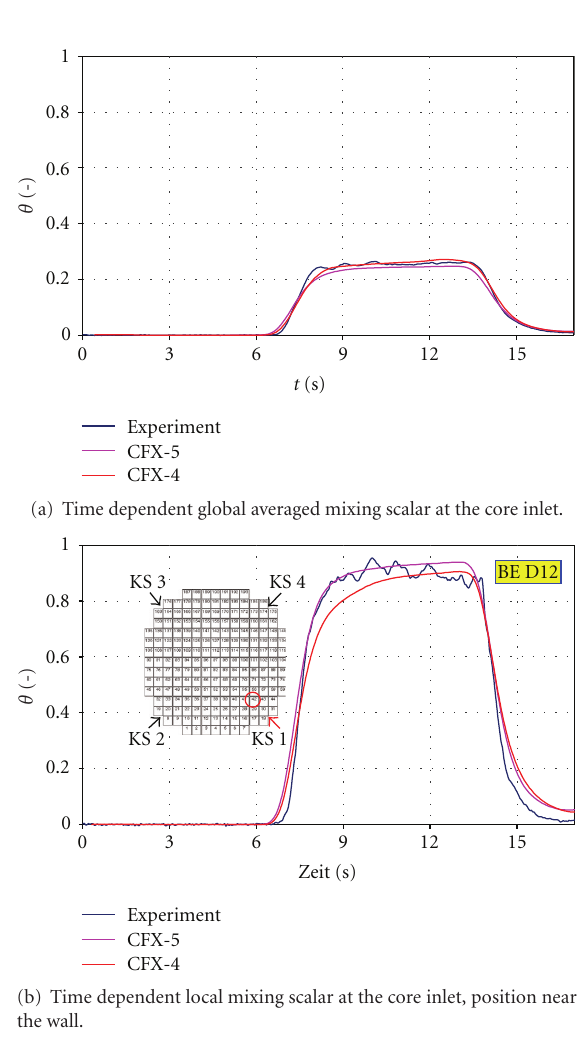
Figure 4: Comparison of the measured and calculated mixing scalar (steady state flow field, 185 m 3